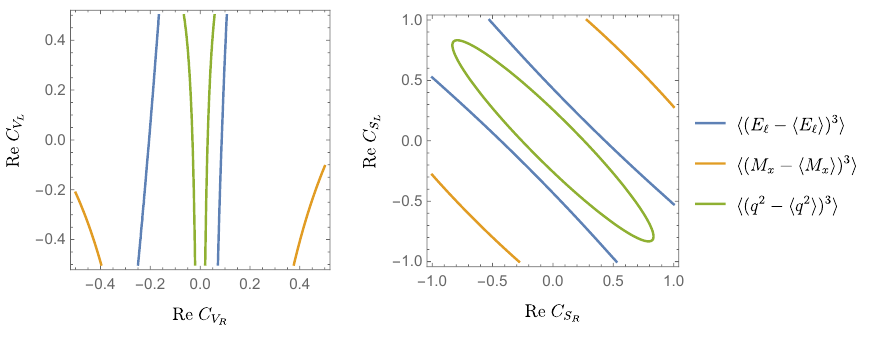
versus C and (right) C versus C V R S L S R L